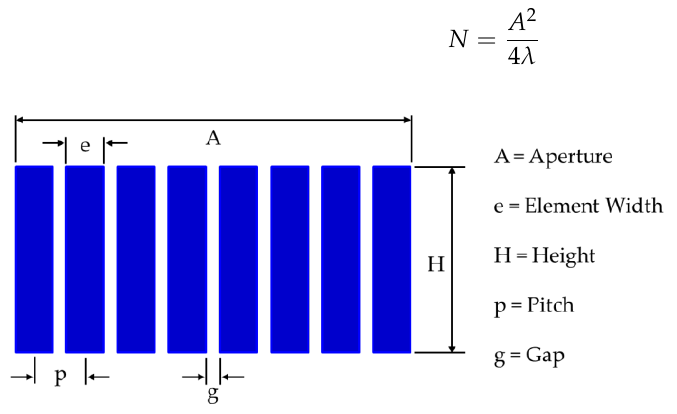
Figure 4. Phased array probe parameters.